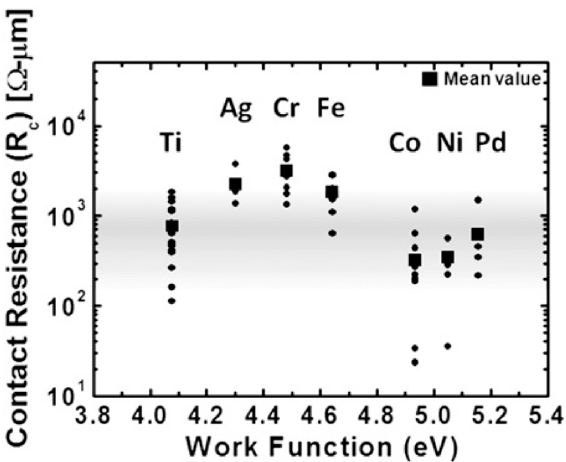
Figure 29. Metal-graphene contact resistance versus metal work-function. The square indicates the mean value. Reproduced from Reference [105] with permission from Elsevier.